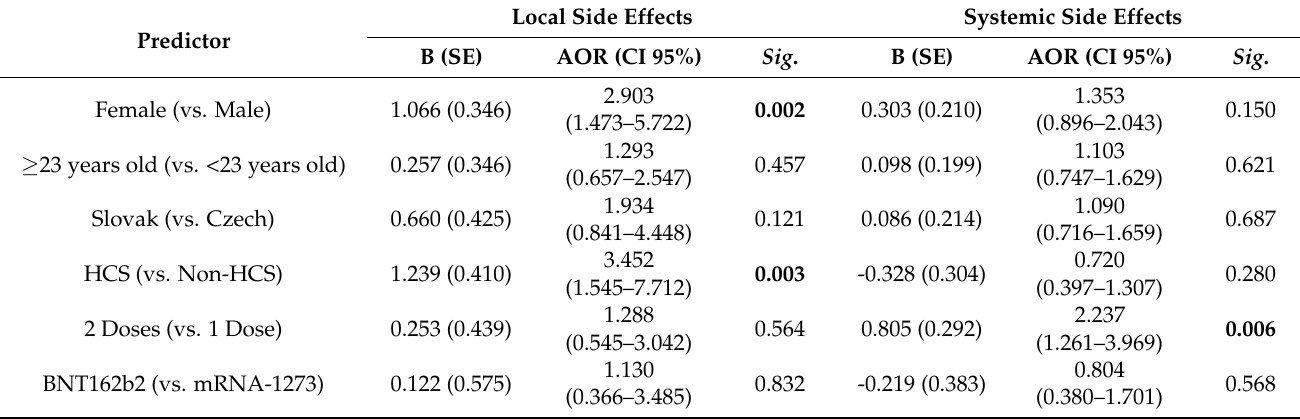
Table 8. Predictors of mRNA-based COVID-19 vaccines side effects (local and systemic side effects) experienced by